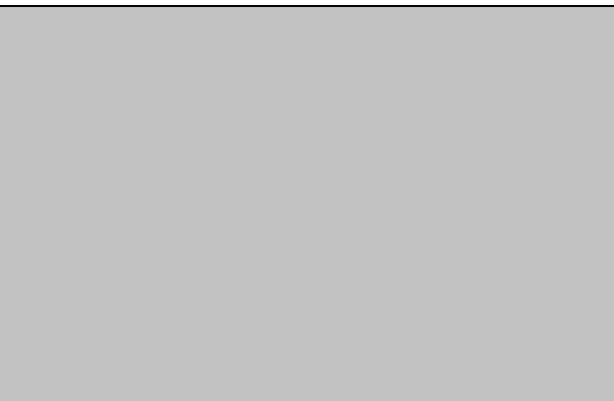
Table IV : Comparision with other